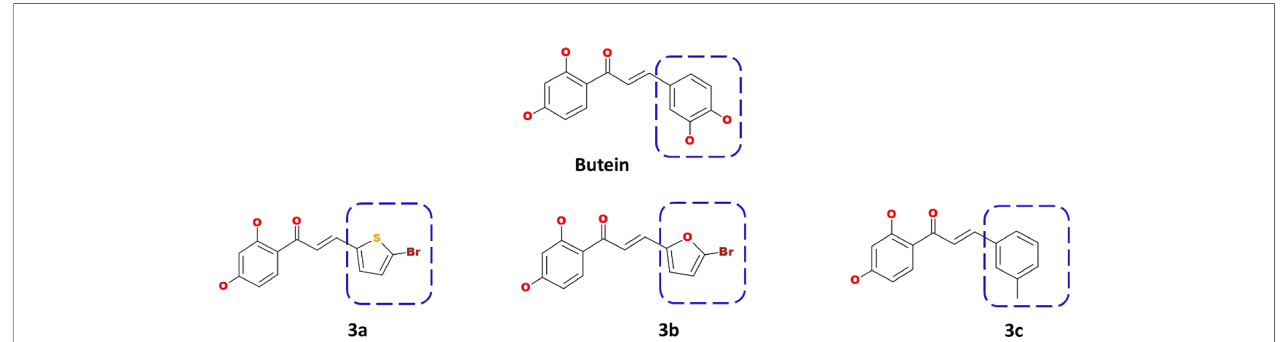
FIGURE 1 | Computational designing of butein compounds modifying the ring B as indicated in